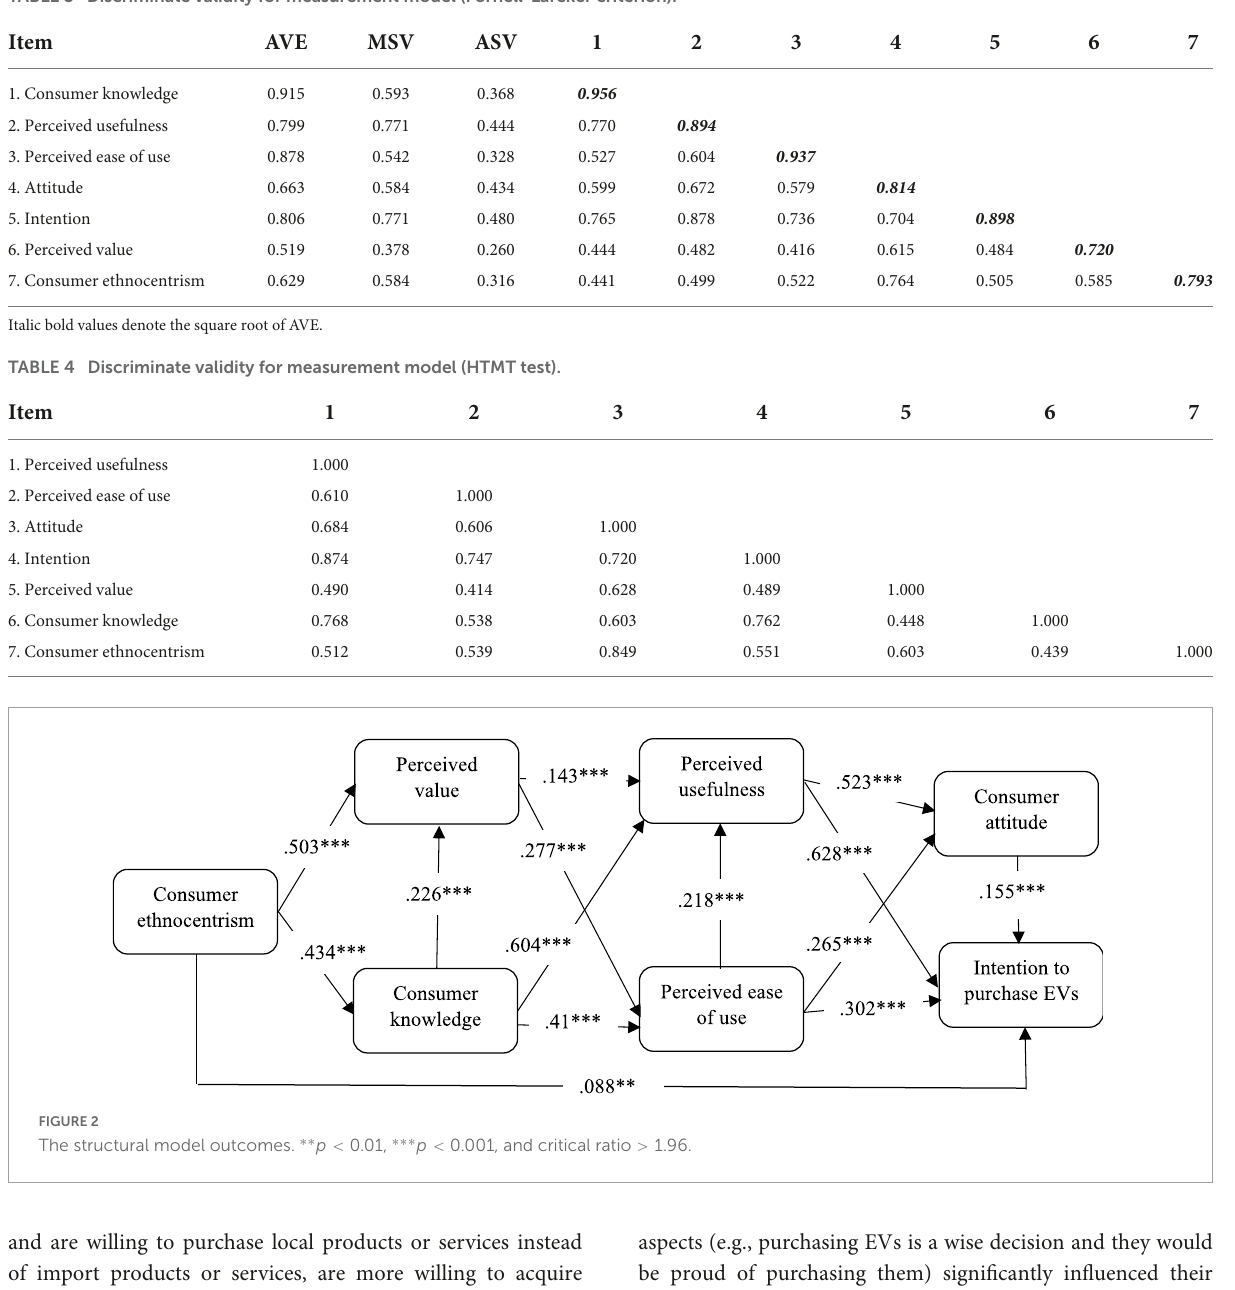
TABLE 3 Discriminate validity for measurement model (Fornell-Larcker criterion).